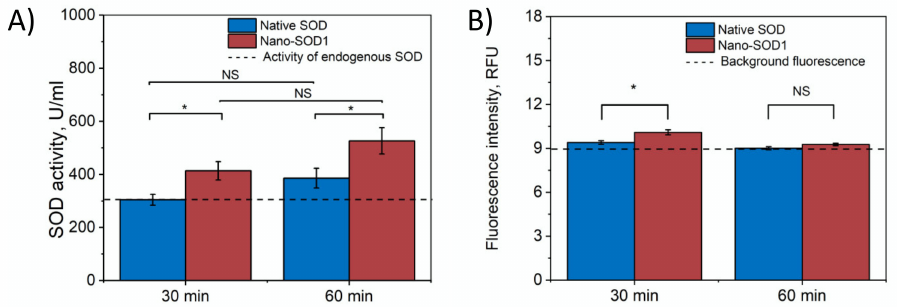
Figure 4. Dynamics of SOD1 and Nano-SOD1 in intraocular fluid after instillation: ( A ) SOD1 activity; ( B ) SOD1 concentration (fluorescence of labeled protein). The dashed lines correspond to the activity of endogenous SOD in tears. The symbols denote the significance levels of differences according to the Mann–Whitney U-test: * p < 0.05; NS—no